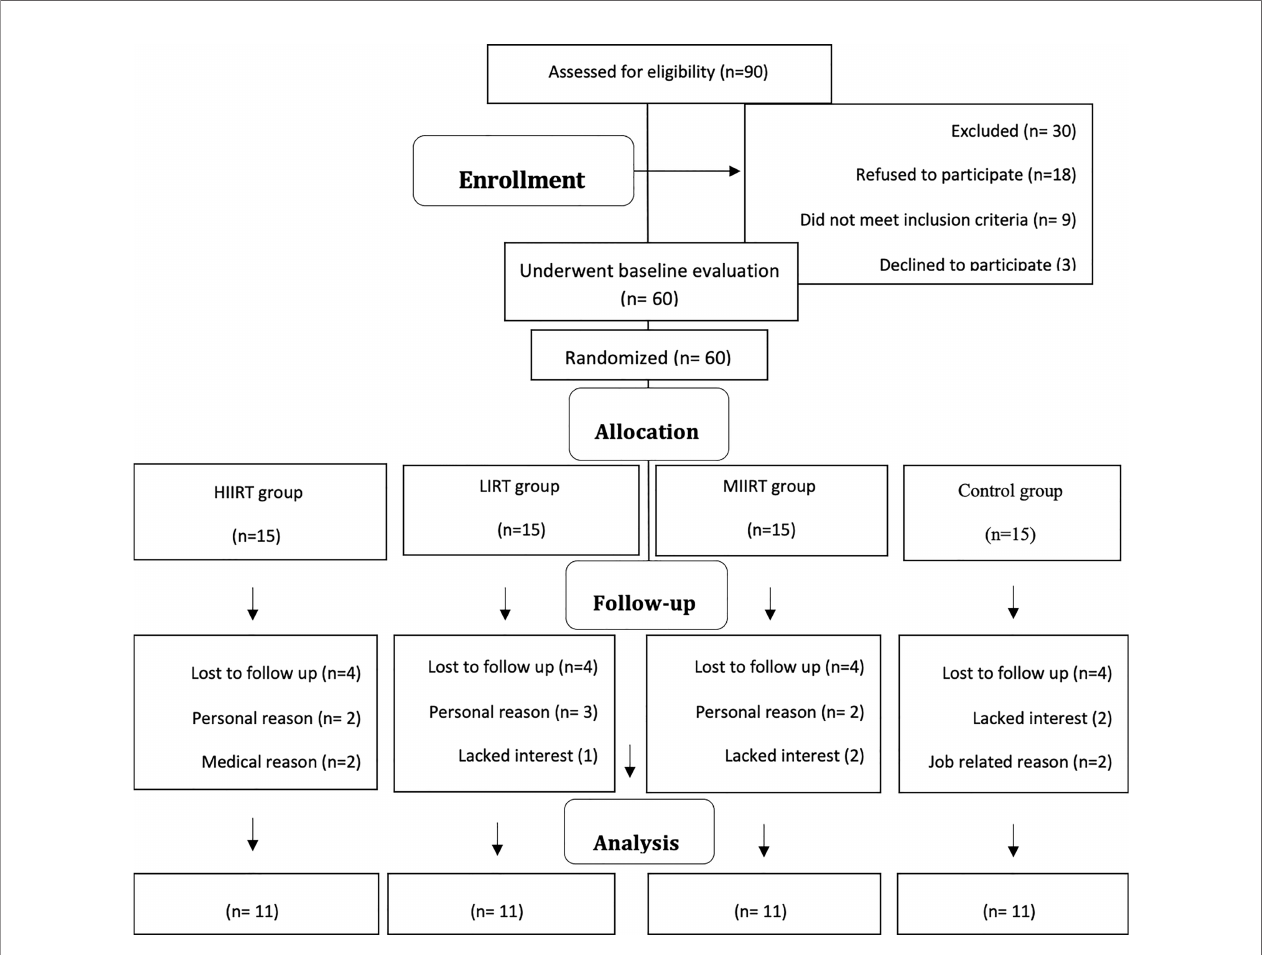
FIGURE 1 | Study fl ow